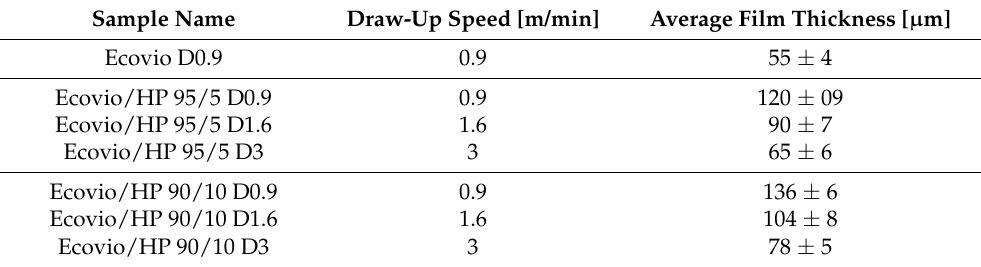
Table 2. Nomenclature and average thickness of film samples produced at different draw-up